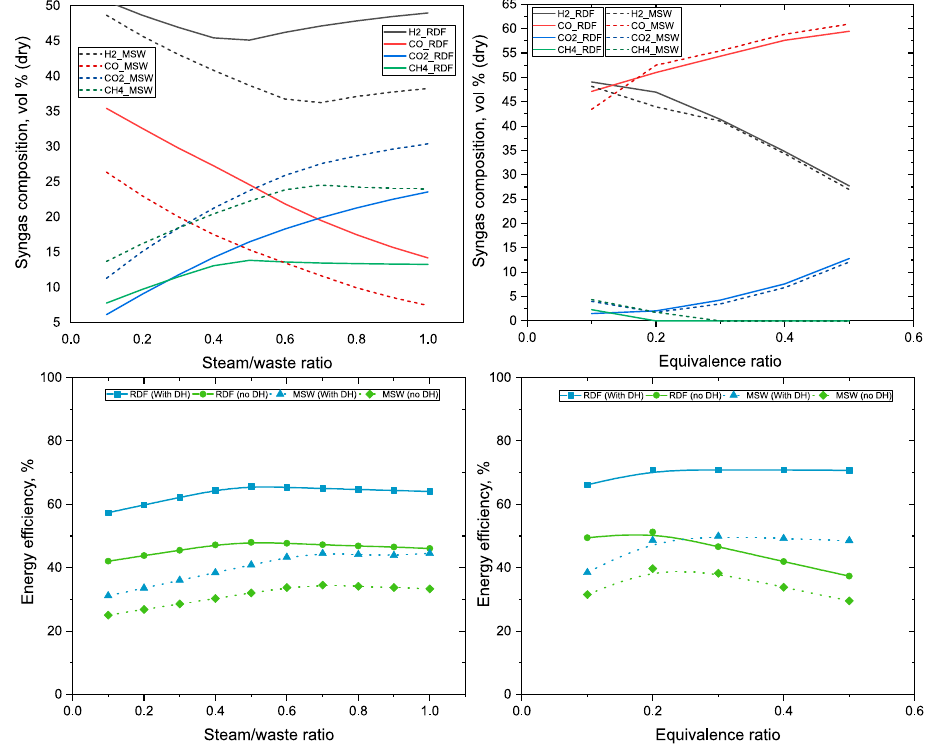
Figure 11. E ff ect of the steam-to-waste ratio and ER on syngas composition and biofuel synthesis from the EFG.